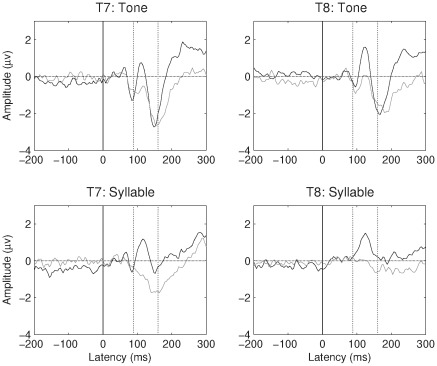
Average response at T7 and T8 for SLI (grey line) and TD (black line) teenagers.